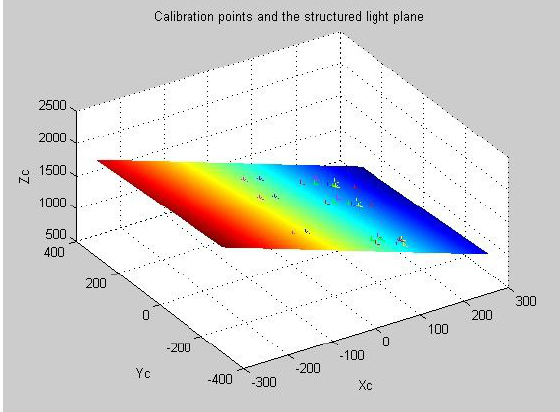
Fig. 5. The calibration points and the light plane in the camera coordinate system